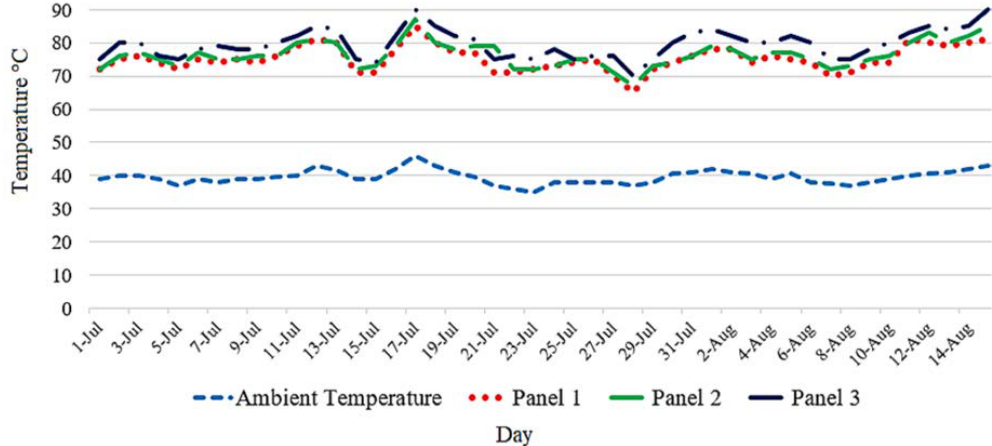
Figure 14. Average daily temperature; ambient and the three panels’ temperatures at the maximum solar radiation per day.